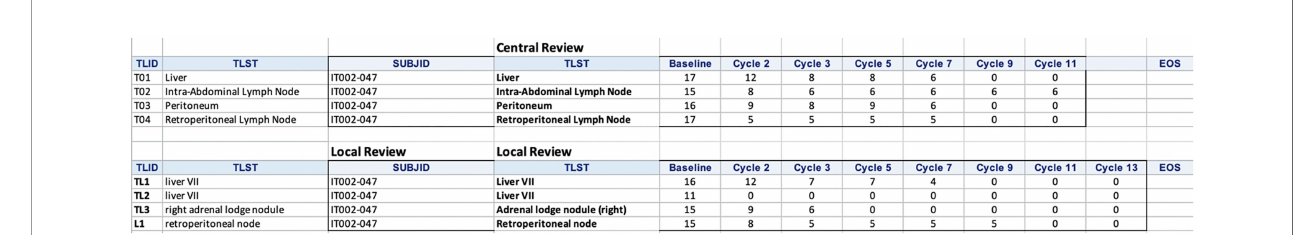
FIGURE 3 | This fi gure demonstrated the exact lesions selected as target lesion for central and local